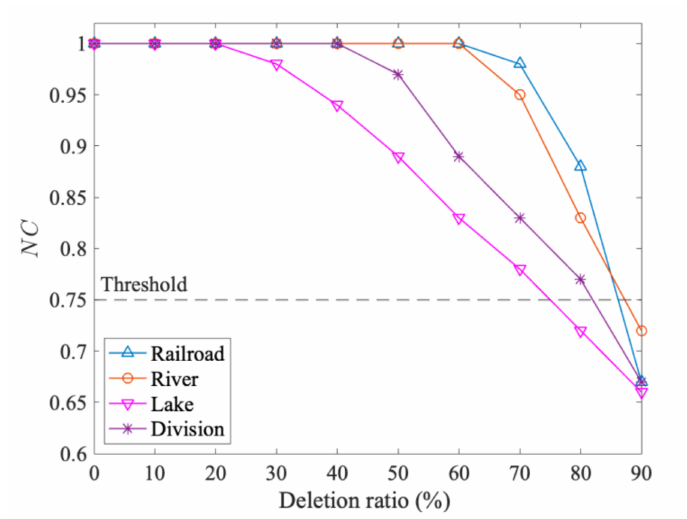
Figure 15. The results after deleting